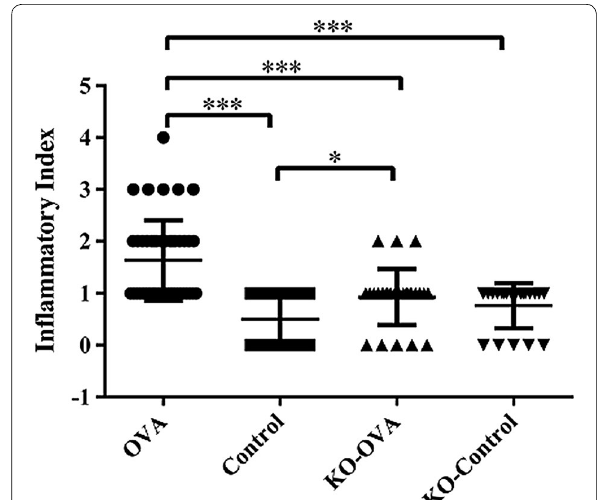
Fig. 3 Inflammatory index of lung tissues from wild type and IL-25 KO mouse models that were sensitized and challenged with OVA or PBS (control) (*p < 0.05 and ***p < 0.001, n